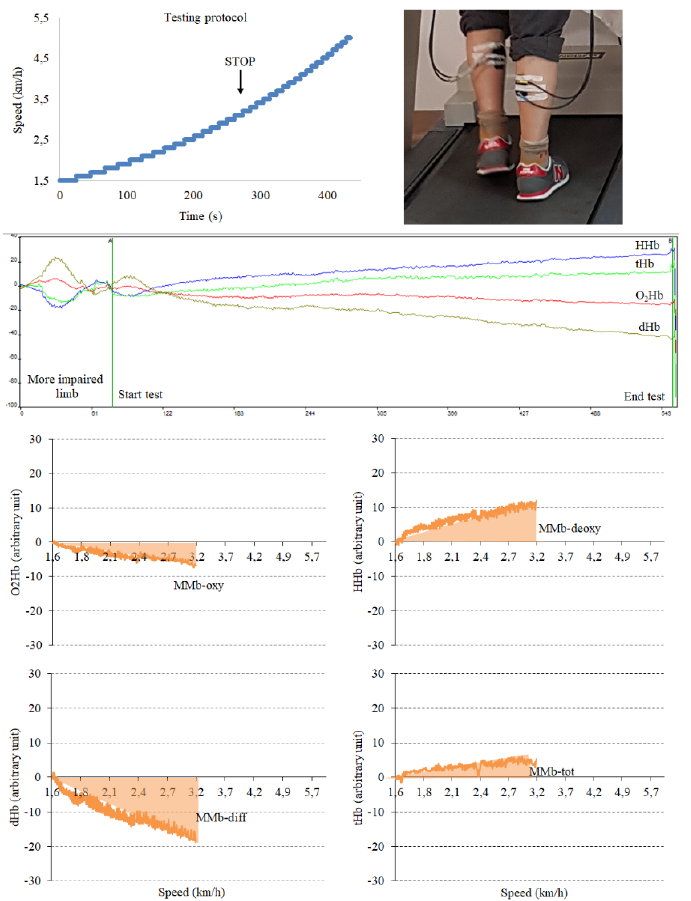
Figure 1. Process of testing, acquisition, elaboration and calculation of the area-under-curve (muscle metabolism biomarkers, MMb) for the four hemoglobin traces.